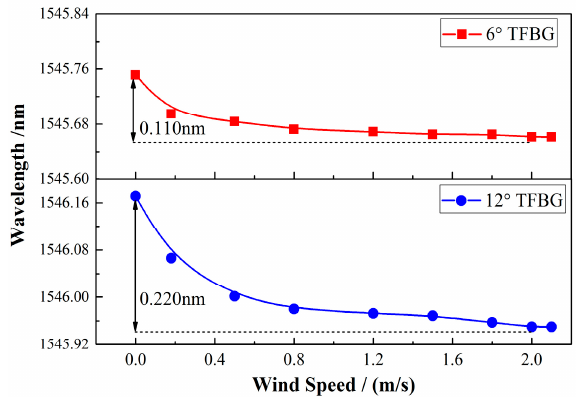
Figure 6. Comparison of the wind speed responses of the anemometer with different angles of TFBG under similar input powers and film thicknesses.